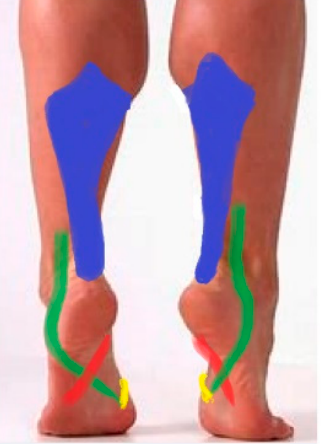
Figure 6. Muscles of system III: m. calf triceps (blue), m. fibularis longus (green), m. tibial posterior (red), m. tibial anterior (yellow). System that lifts, supports, and shapes the medial longitudinal arch as well as stiffing the lever of the foot.